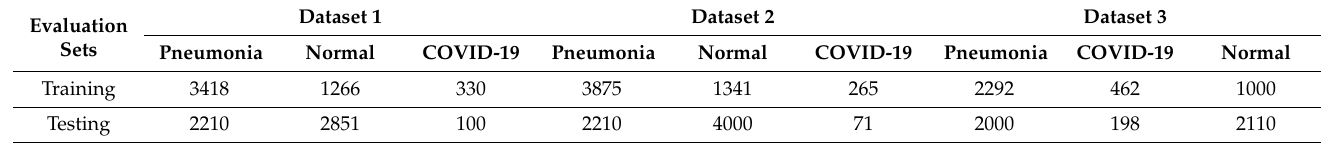
Table 1. Dataset